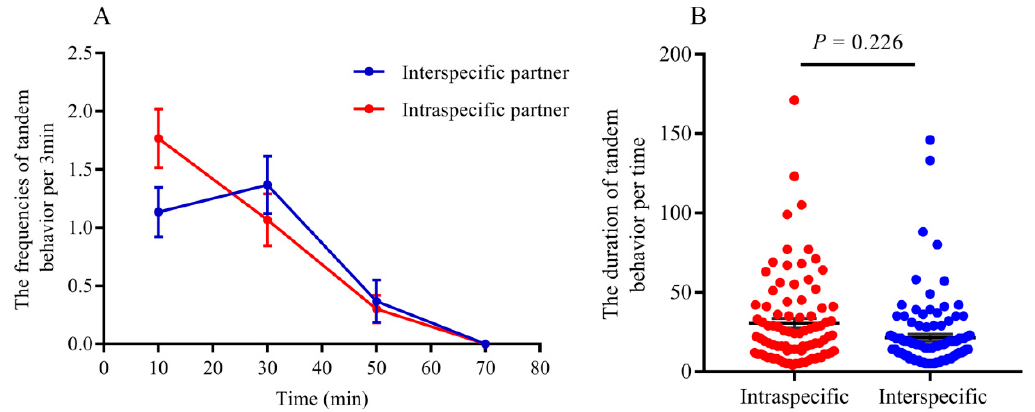
Figure 2. ( A ): The frequencies of tandem behavior observed in intraspecific and interspecific partners. ( B ): The duration of tandem behavior per time (unit: min). There were no significant di ff erences in frequencies of tandem behavior between intraspecific and interspecific partner at each observing point (GLMM: F = 0.34, p = 0.56). Similarly, there were no significant di ff erences in the duration of tandem between them ( t = 2.31, p = 0.22).